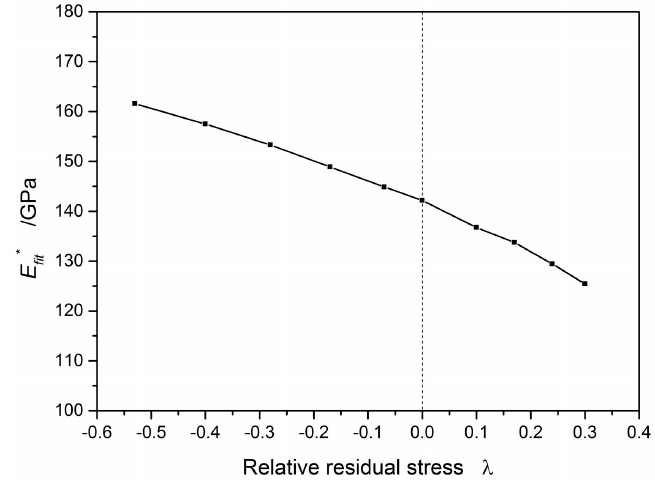
Figure 4. Indentation modulus E* fit as a function of relative residual stress.